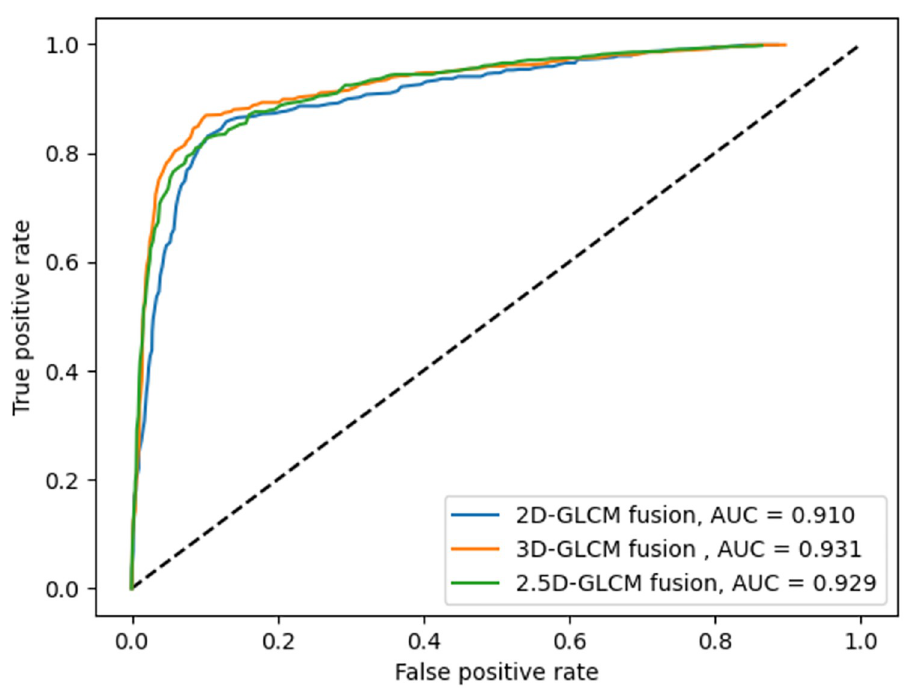
Fig 8. ROC curves for three fusion models and their corresponding micro-averaged AUC values.